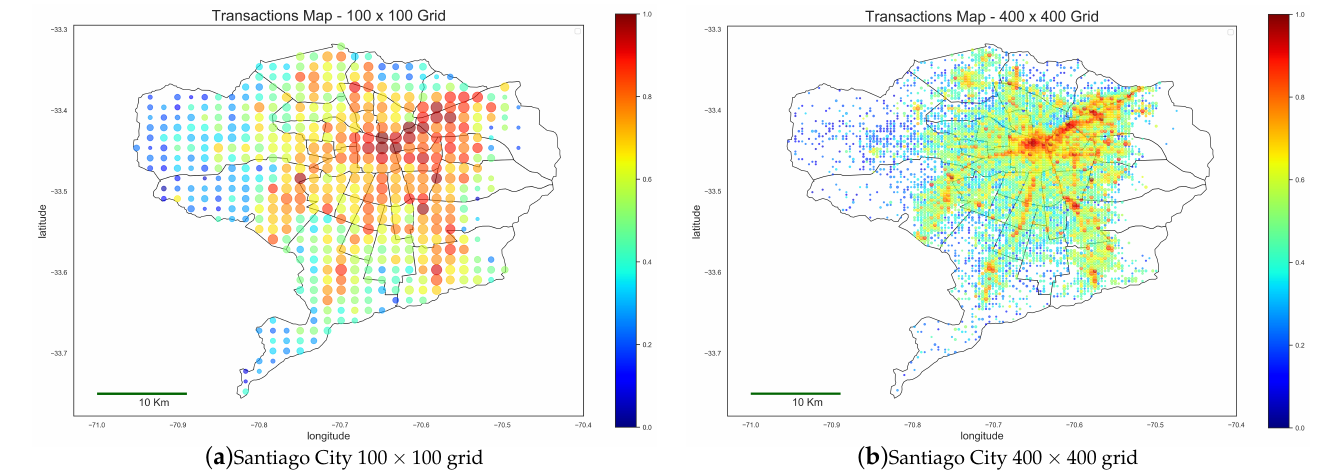
Figure 3. Spatial aggregation grids over Santiago City .